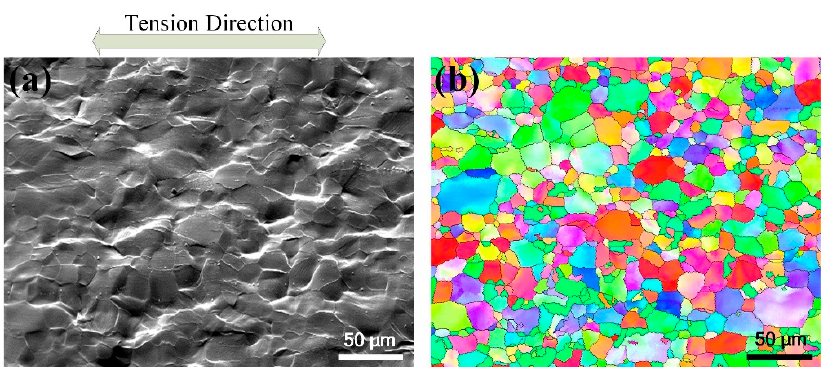
Figure 2. SEM map ( a ) and the corresponding IPF ( b ) after 10% tensile strain in Mg–8.0Gd–3.0Y–0.5 Zr alloy.